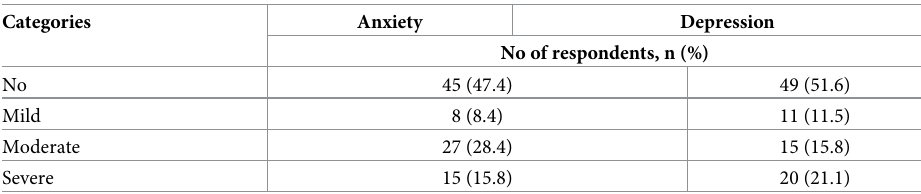
Table 2. Anxiety and depression among the patients (n =